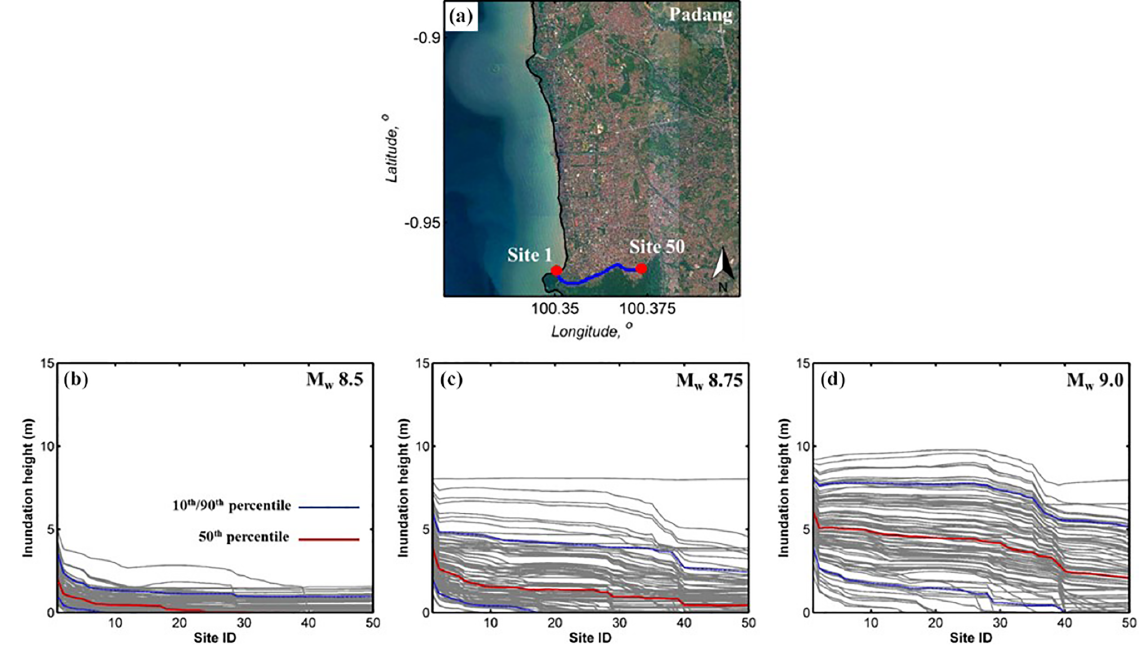
Figure 13. (a) Site location. (b) Maximum tsunami inundation height in the third river of Padang for the M w 8.5 scenario. (c) Maximum tsunami inundation height in the second river of Padang for the M w 8.75 scenario. (d) Maximum tsunami inundation height in the third river of Padang for the M w 9.0